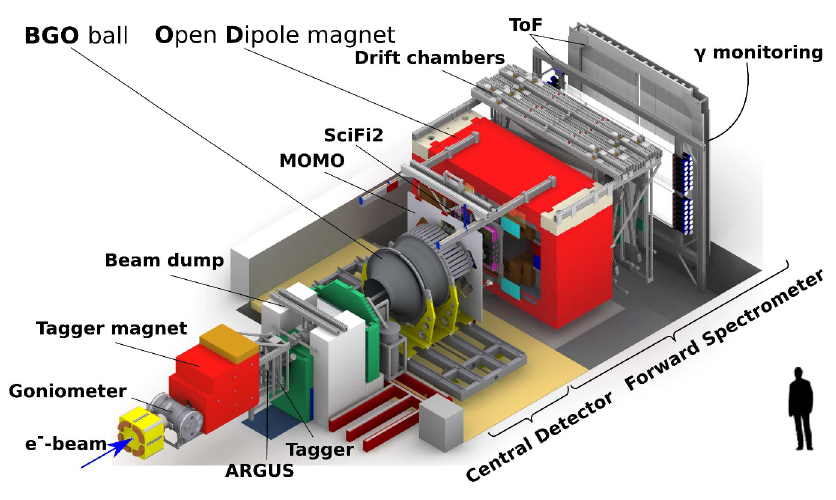
Figure 2. Overview of BGO-OD